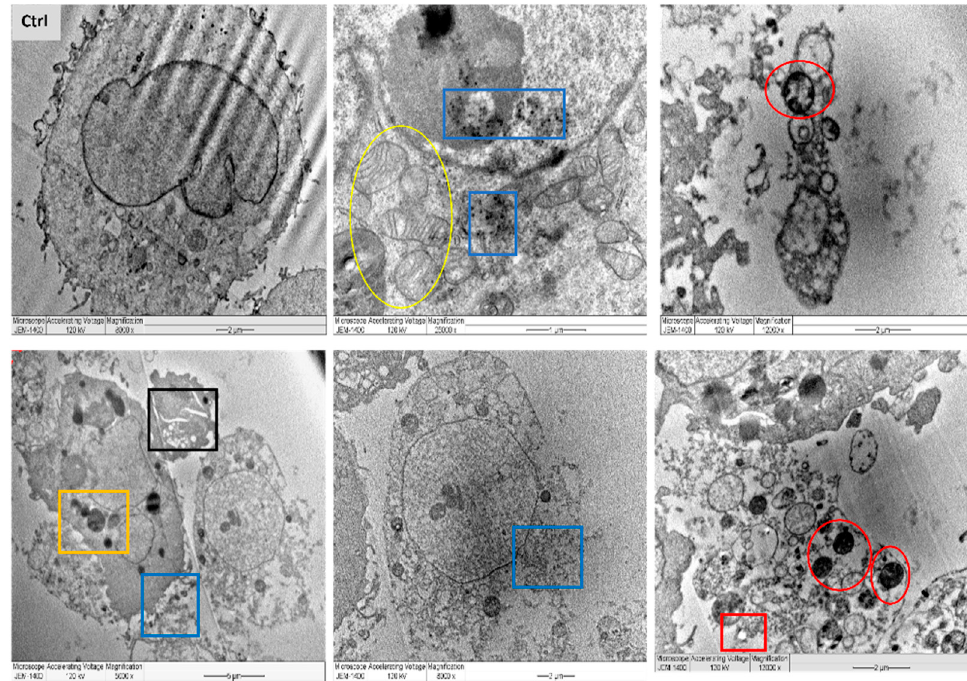
Figure 13. TEM images of MDA-MB-231 cell lines, where untreated cell (Ctrl) exhibiting rounded shape cell with complete organelle and nucleus. Image magnification ×8000; bar 2 µm. Other images at varied magnification show the ultrastructural alteration in cell treated with L-AgNPs displaying early apoptosis characteristics such as: chromatin condensation and over whole cell shrinkage as well as late apoptosis: lipid droplet (red square), peroxisomes (yellow square) and enlarged mitochondria (yellow circle) and damaged mitochondria (red circle). Damaged cancerous cells are clearly observed with R-AgNPs located in the cytoplasm, outer cell and nucleus membranes (blue squares).